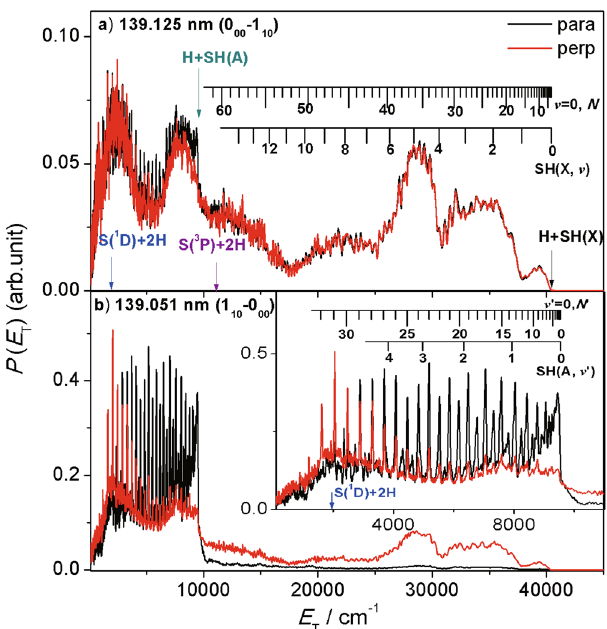
Fig. 3 The H + SH product translational energy ( P ( E T )) spectra from H 2 S photodissociation. P ( E T ) spectra derived from H atom TOF spectra following photodissociation of a jet-cooled 30% H 2 S in Ar sample at λ = a 139.125 and b 139.051 nm with ε phot aligned, respectively, parallel ( θ = 0°, black) and perpendicular ( θ = 90°, red) to the detection axis. The combs in a and in the inset to b show the E T values associated with formation of H atoms in conjunction with selected rovibrational levels of the primary SH (X) and SH(A) fragments, respectively. The energetic limits of these dissociation channels are marked by coloured arrows. The raw data are provided as a Source Data fi